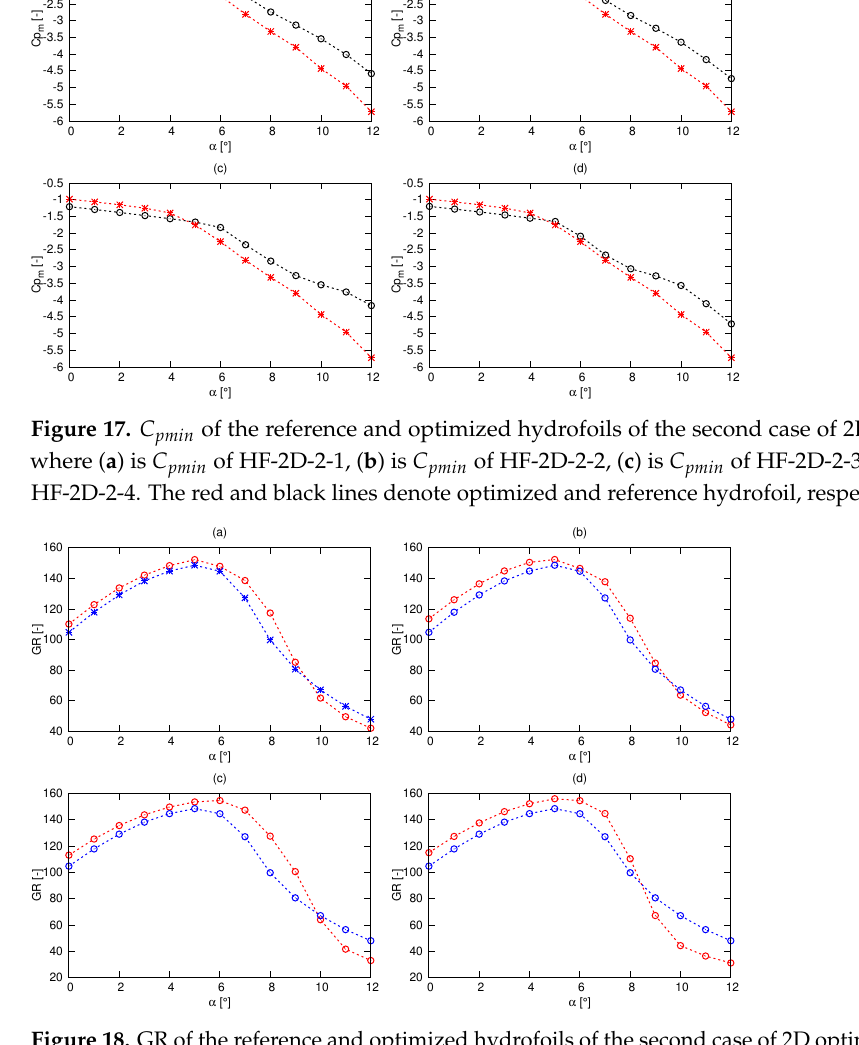
Figure 18. GR of the reference and optimized hydrofoils of the second case of 2D optimization, where ( a ) is GR of HF-2D-2-1, ( b ) is GR of HF-2D-2-2, ( c ) is GR of HF-2D-2-3 and ( d ) is GR of HF-2D-2-4. The red and blue lines denote optimized and reference hydrofoils,